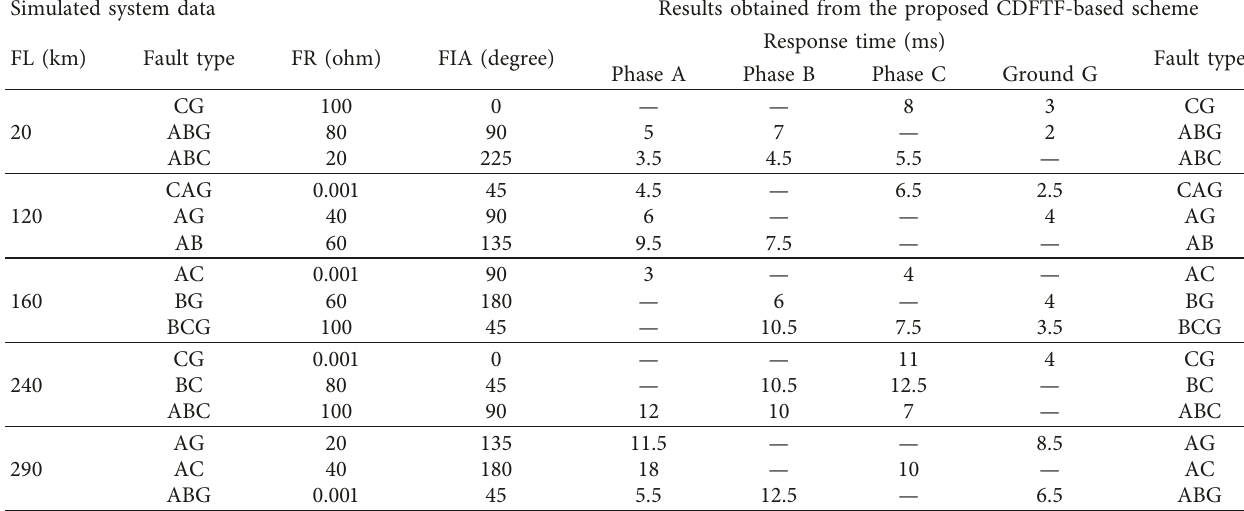
Table 12: Effect of fault resistance, fault inception angle, and fault location.